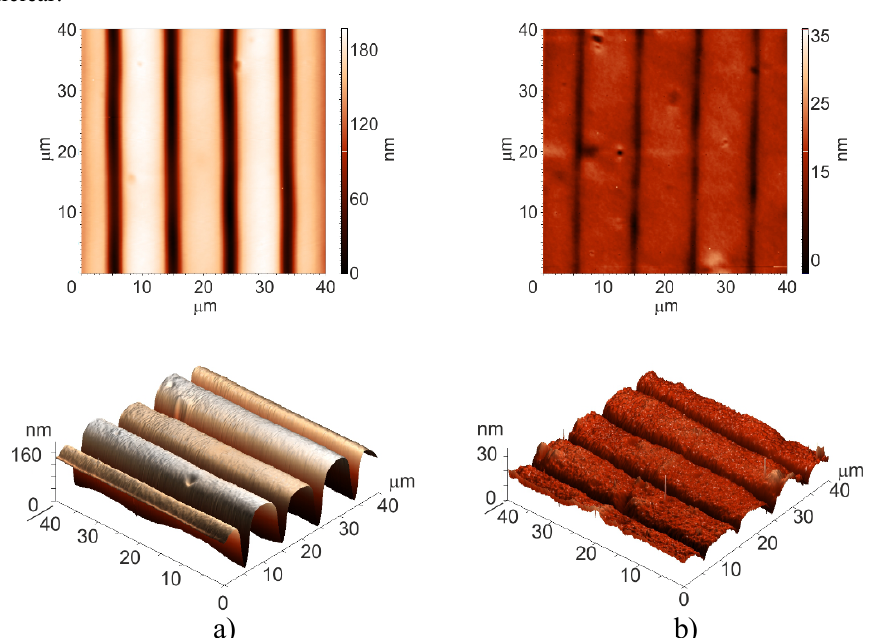
Fig. 4. AFM images of the PMMA films irradiated with the same condition: a) PMMA film on glass; b) free-standing PMMA film (front side).